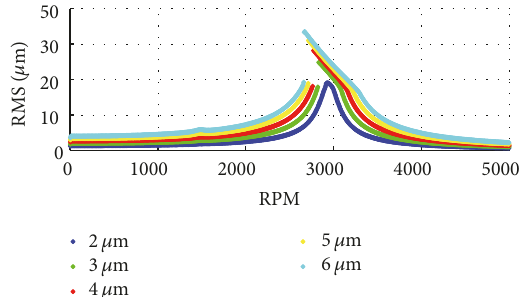
Figure 12: RMS of the different DTE curves obtained by using different values of the amplitude of the harmonic component at the meshing frequency.